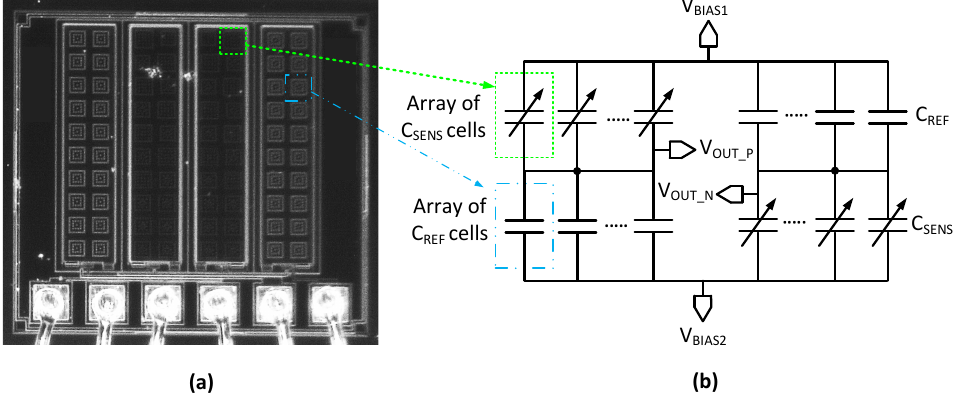
Figure 5. MEMS die photograph ( a ); and equivalent model schematic based on sensor and reference cell arrays ( b ) without parasitic capacitance.